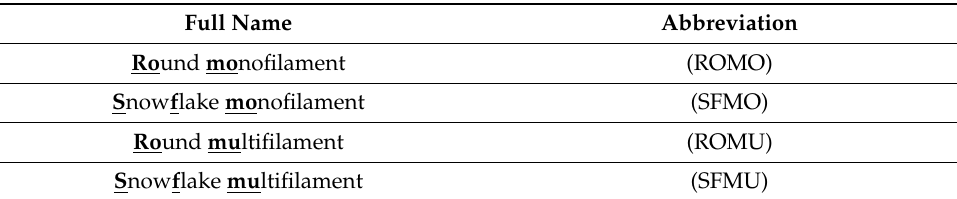
Table 2. Fiber morphologies used for PBS exposure at 37 °C.